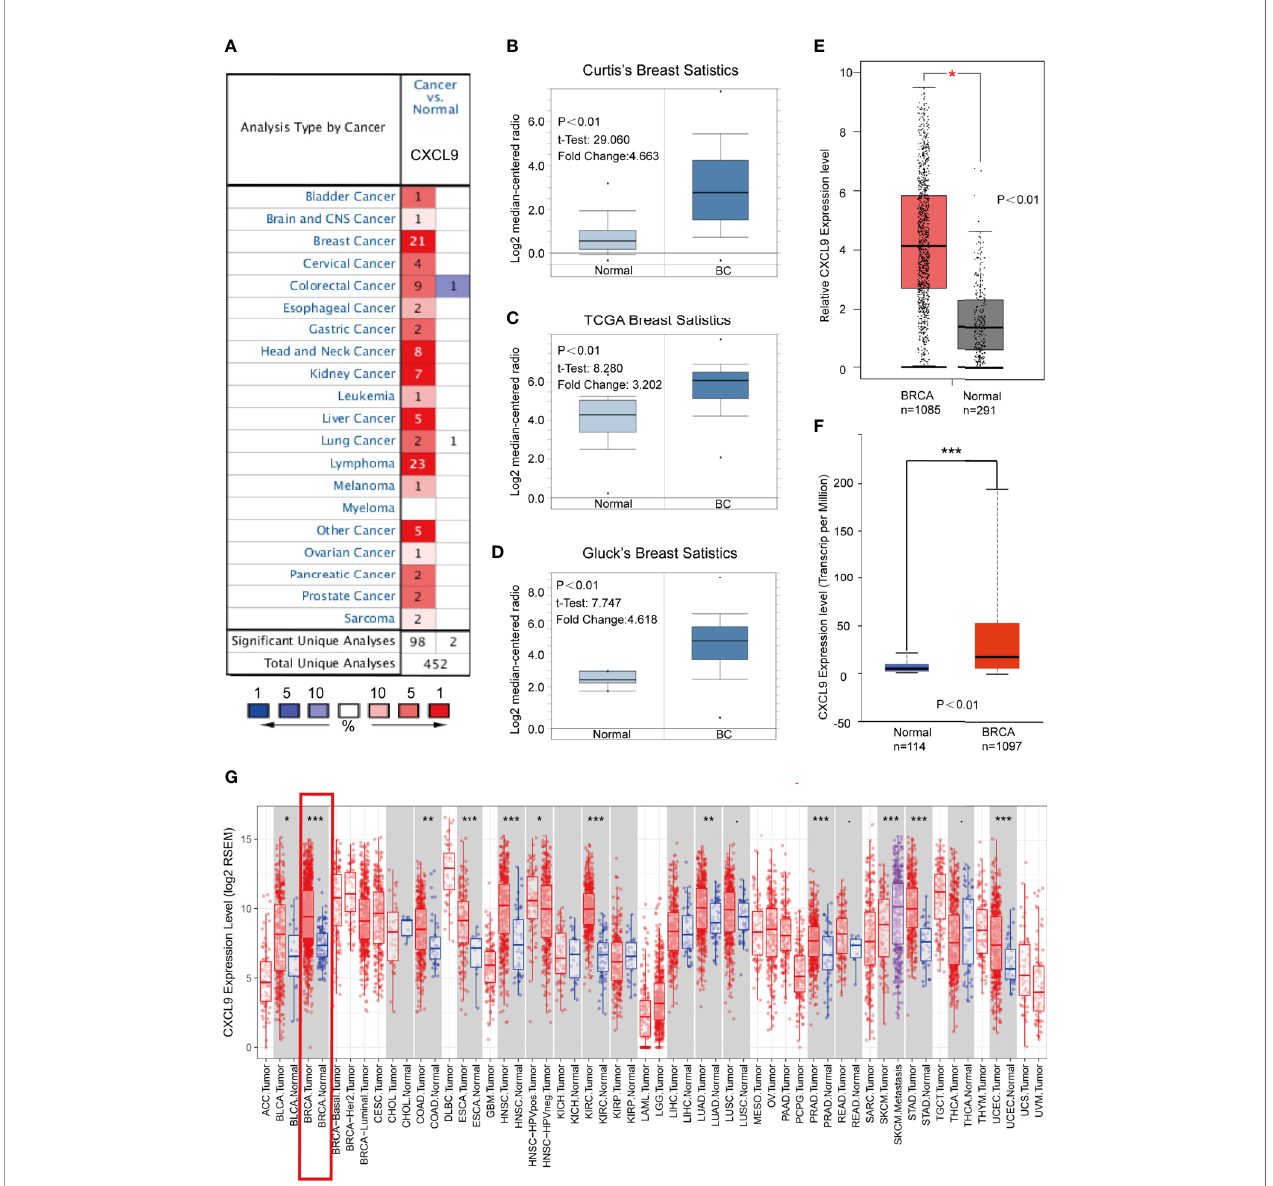
FIGURE 1 | CXCL9 was signi fi cantly overexpressed in breast cancer compared with normal breast tissue. (A) Expression of CXCL9 (cancer vs. normal tissue) analysed with ONCOMINE database. The graphic demonstrated the numbers of datasets with statistically signi fi cant mRNA over-expression (red) or down- expression (blue) of the target gene. The p value threshold is 0.01. The number in each cell represents the number of analyses that meet the threshold within those analysis and cancer types. The gene rank was analysed by percentile of target gene in the top of all genes measured in each research. Cell colour is determined by the best gene rank percentile for the analyses within the cell. (B – D) Comparison of CXCL9 expression in Curtis ’ s Breast Dataset (B) , TCGA Breast Dataset (C) and Gluck ’ s Breast Dataset (D) from ONCOMINE. (E) The mRNA expression of CXCL9 in BC tissues from GEPIA2 database. (F) The expression of CXCL9 in BC tissues from UALCAN database. (G) Expression of CXCL9 (cancer vs. normal tissue) analysed among different tumor types from the TCGA in TIMER database (shown in red frame). The t-test was used to estimate the signi fi cance of difference in gene expression levels between groups. *P < 0.05, **P < 0.01, ***P <